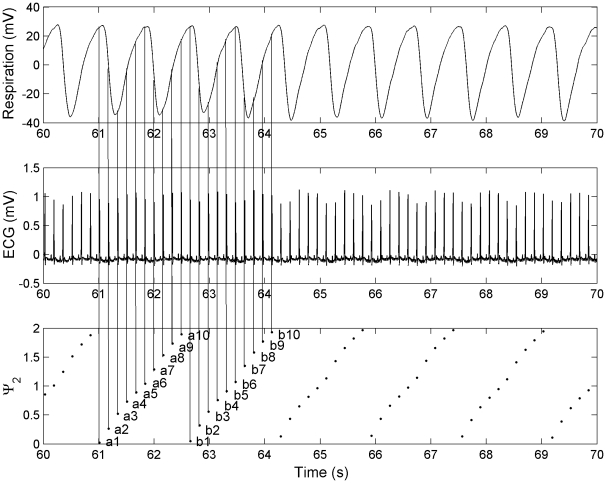
Illustration of the generation of synchrogram from the respiratory and ECG signals.a1, a2,…,a10 and b1, b2,….,b10 in the synchrogram plot represent the respiratory phases, based on the time points of R-peaks, for the first two and the following two respiratory cycles.